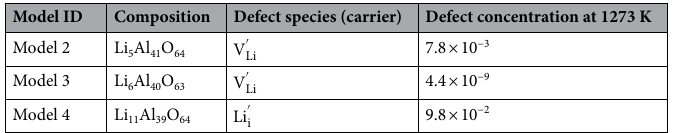
Table 1. Defect generation energies and defect concentrations at 1273 K for Models 2–4 evaluated using first- principles